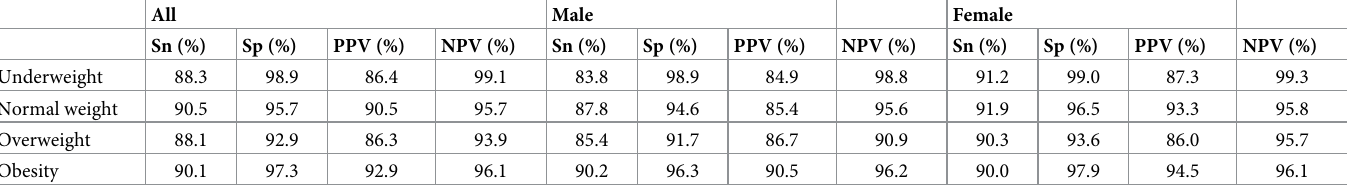
Table 5. Sensitivity, specificity, positive predictive value, and negative predictive value of self-reported BMI classifications by gender. All